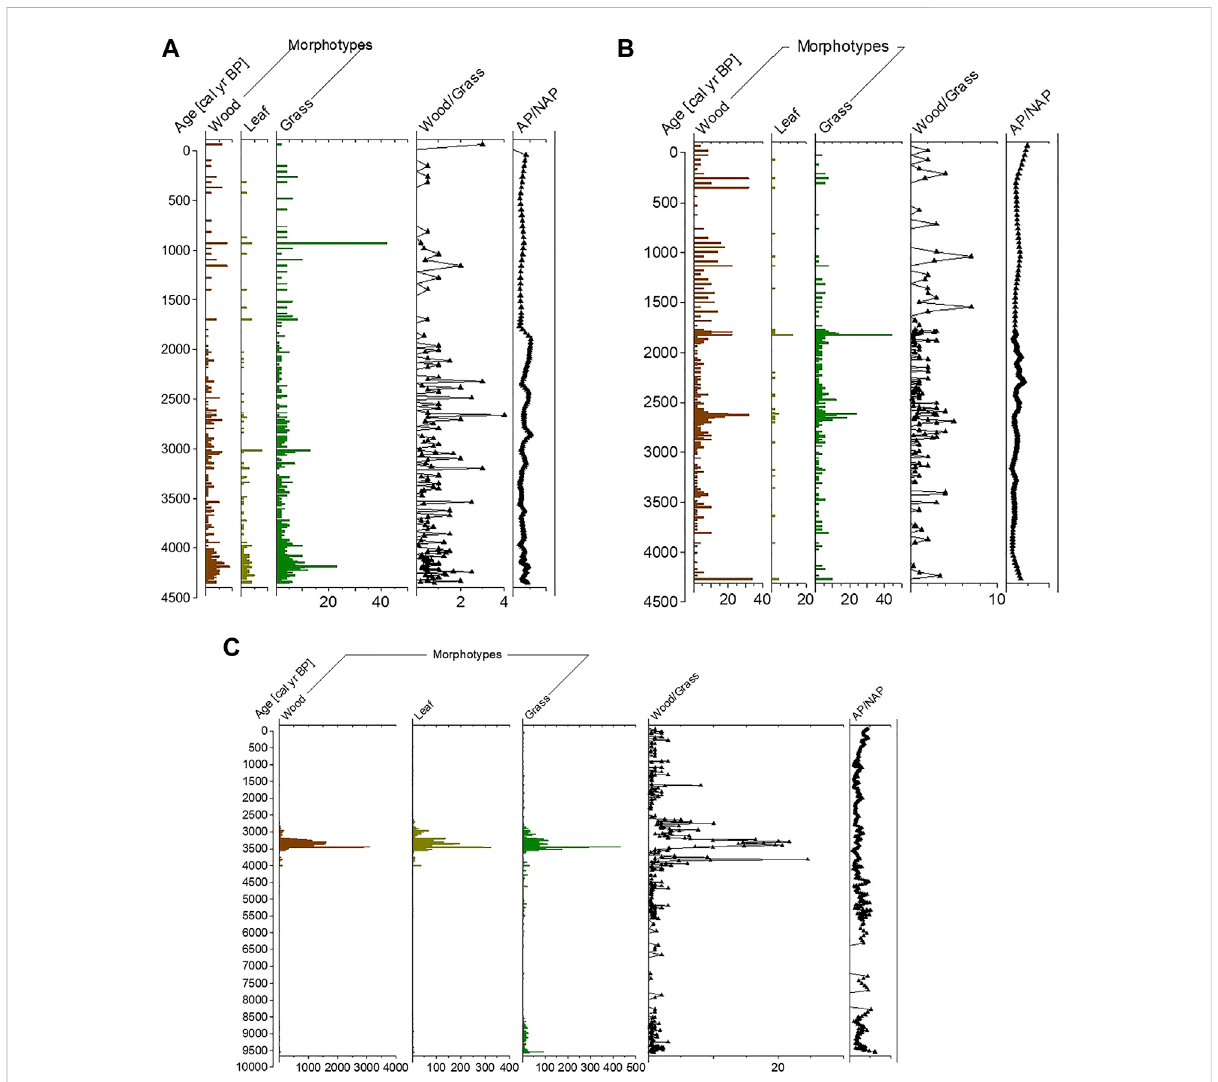
FIGURE 7 Macro-charcoal morphotypes (total counts per sample), wood/grass morphotype ratios, and AP/NAP ratios: (A) site OL1; pollen data from Li (unpublished), (B) site OL2; pollen data from Saindovdon (unpublished), and (C) site OL3; charcoal and pollen data from Unkelbach et al.